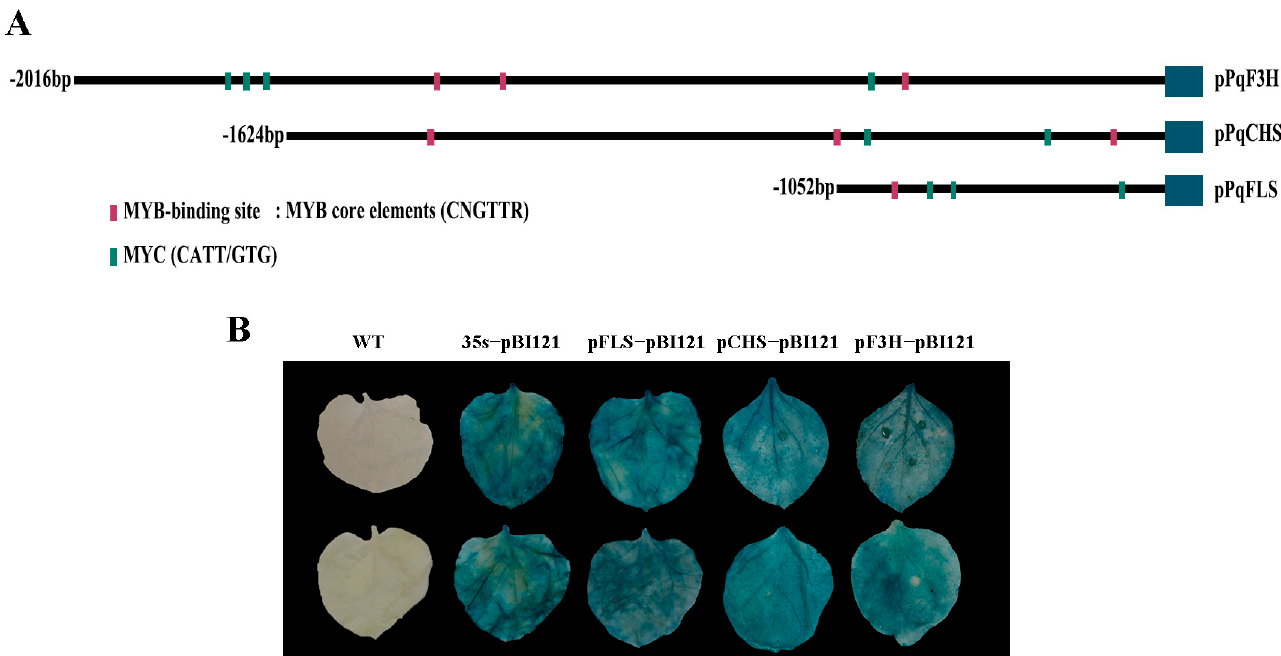
Figure 6. Promoter analysis of flavonol synthesis-related gene. ( A ) The distribution of MYB binding elements in the promoter sequences of PqCHS, PqF3H, and PqFLS . ( B ) GUS activity analysis of promoters from PqCHS , PqF3H , and PqFLS .